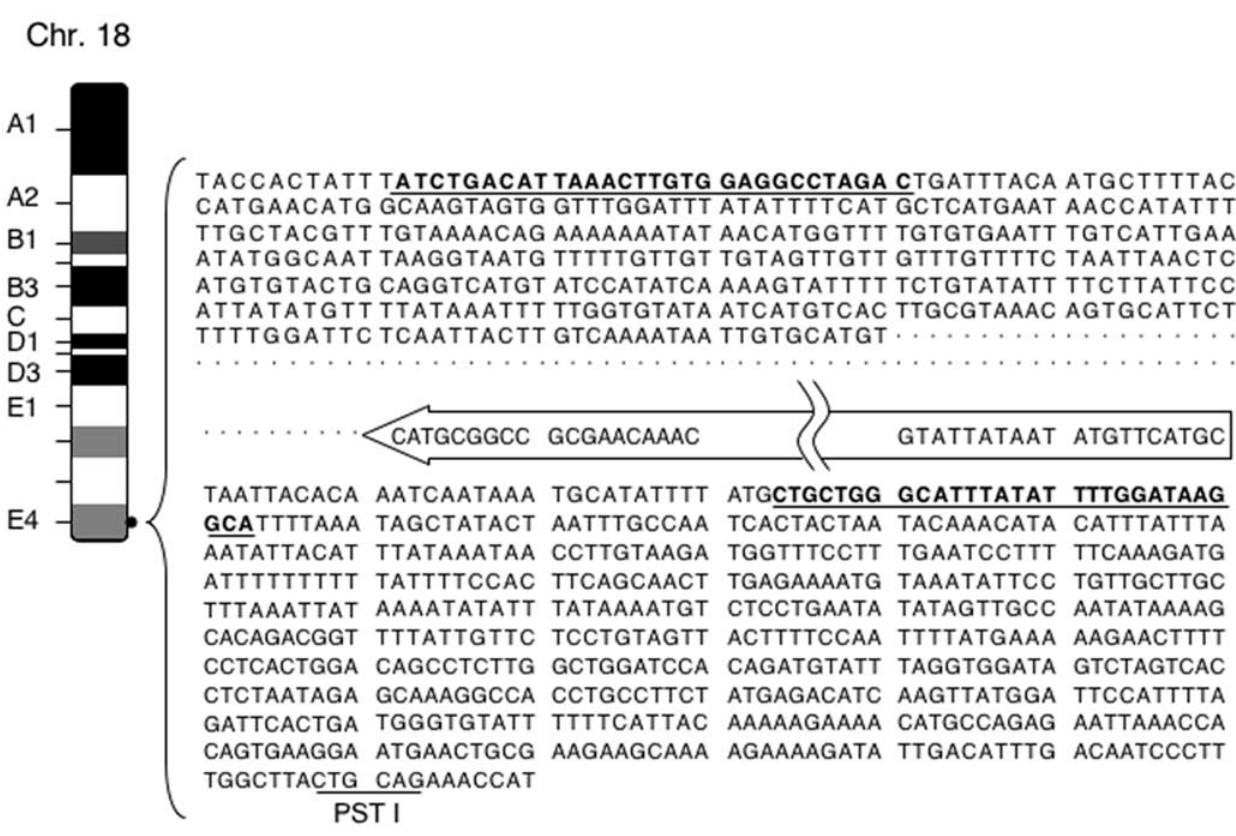
Figure 3. TH-MYCN transgene is integrated in a Chr18qE4 locus. The sequence of the transgene/host DNA junctions are shown. Bold letters with underlines indicate the primers (Chr18F5 and Chr18R2) using for genotyping. PstI site is located 610 bp up-stream of the transgene. Dotted lines indicate 1,063 bp of the genomic DNA deletion. It should be noted that the deletion was shown down-stream of the transgene for convenience (see results and discussion). doi:10.1371/journal.pone.0006902.g003 PLoS ONE |